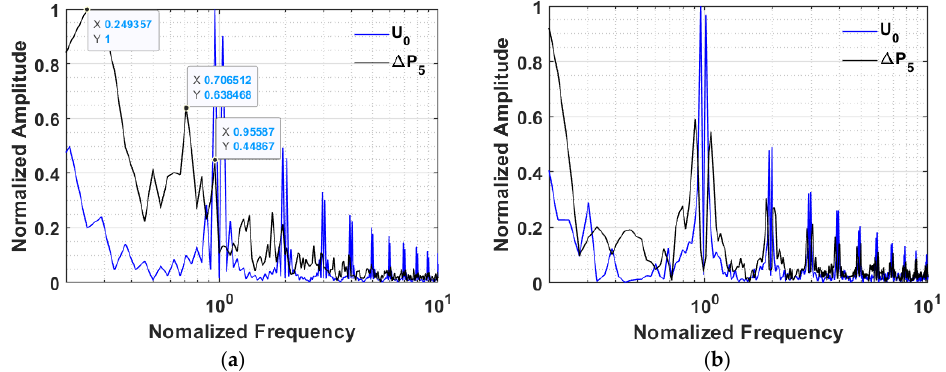
Figure 7. ( a ) Frequency response of the velocity and lower region pressure drop signals for the hydrophobic nanosilica. ( b ) Frequency response of the velocity and lower region pressure drop signals for the hydrophilic nanosilica.